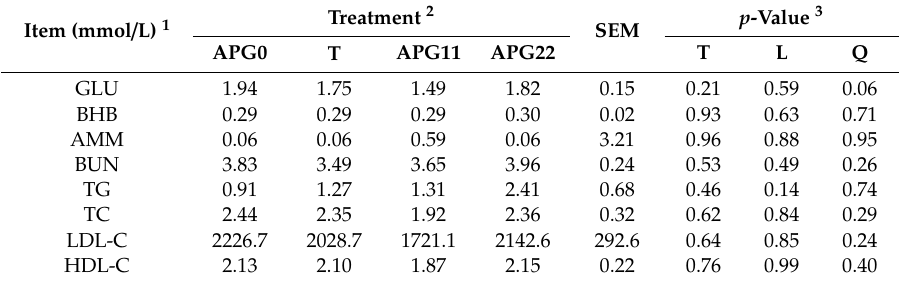
Table 3. E ff ects of APG supplementation on the blood index of lactating cows.